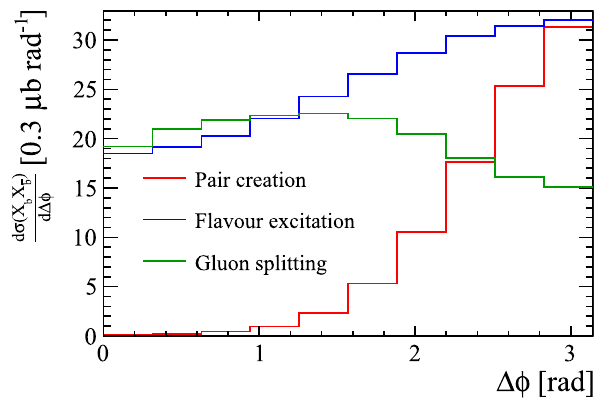
Fig. 2 Differential cross-section in the transverse angle between the two b -hadrons in Pythia simulations with exactly two b -hadrons